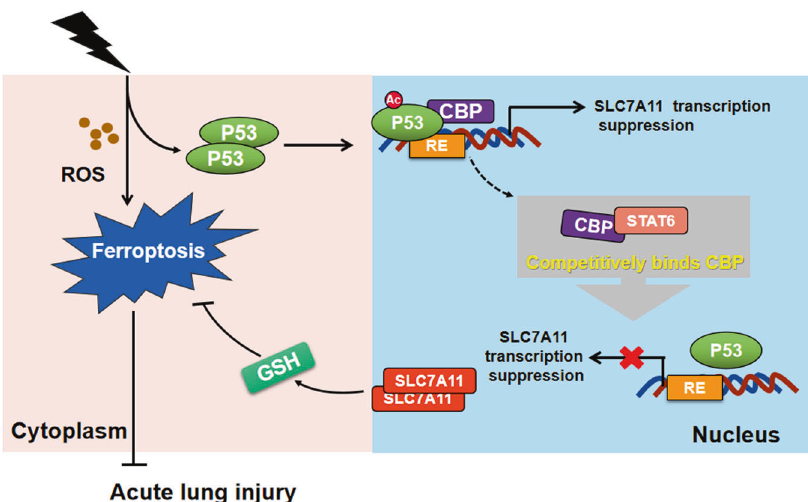
Fig. 8 Proposed model for the regulation of STAT6 on ferroptosis. STAT6 competitively binds with CBP, suppressing the association of P53 and CBP, decreasing the acetylation of P53, restoring SLC7A11 expression and alleviating acute lung